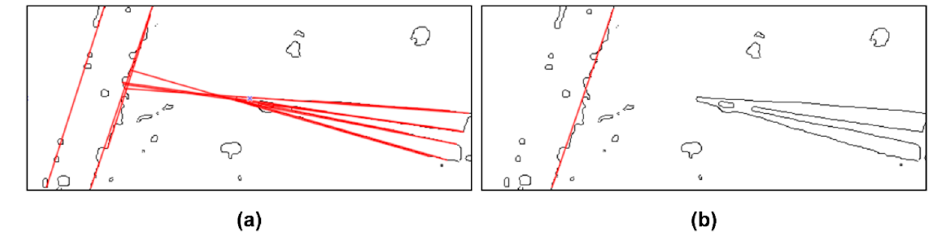
Figure 18. ( a ): Line extraction. ( b ): Line screening.